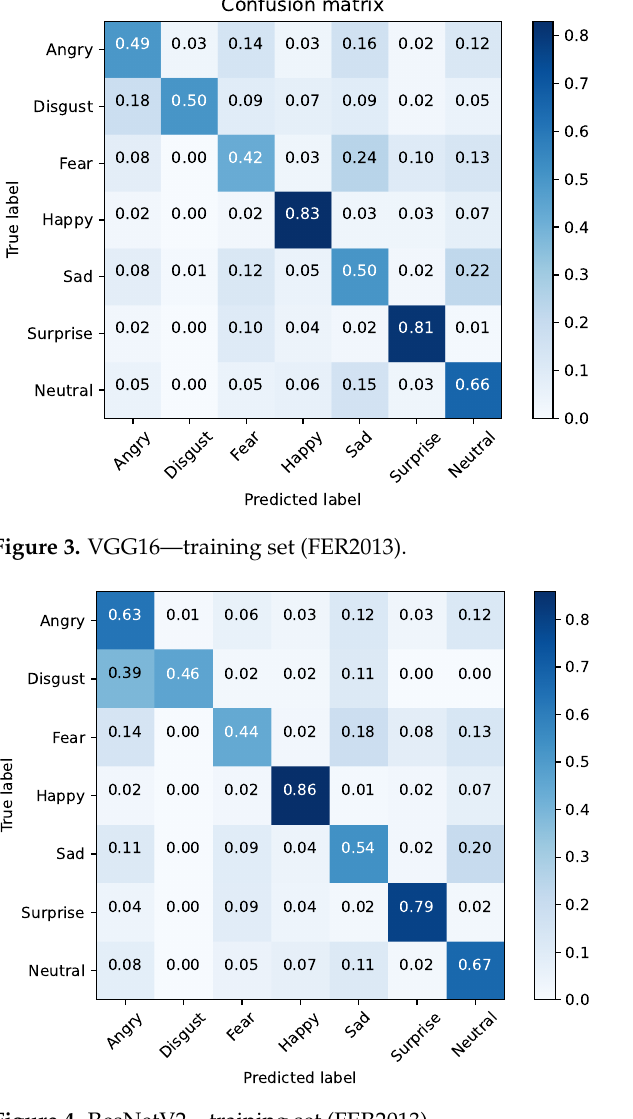
Figure 4. ResNetV2—training set (FER2013).